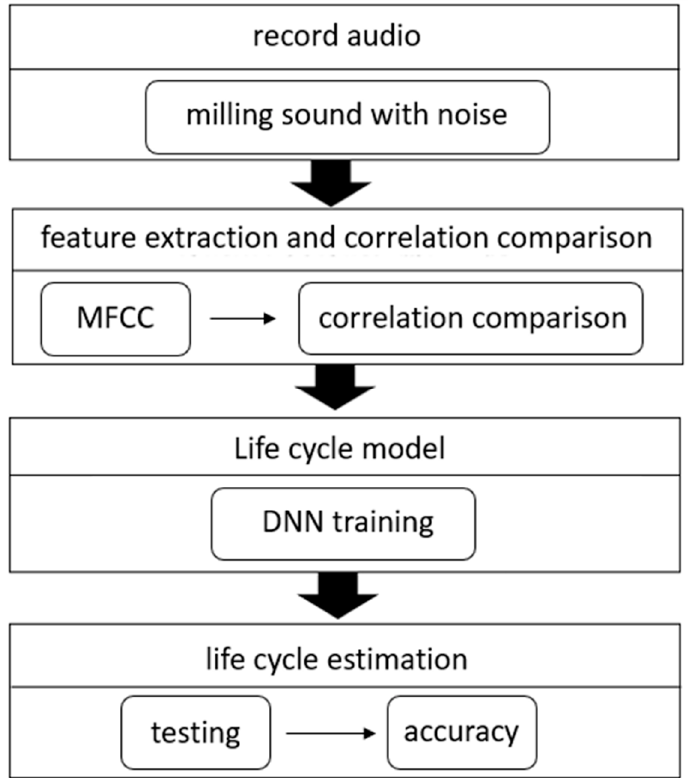
Figure 1. Flow chart of life cycle prediction system.